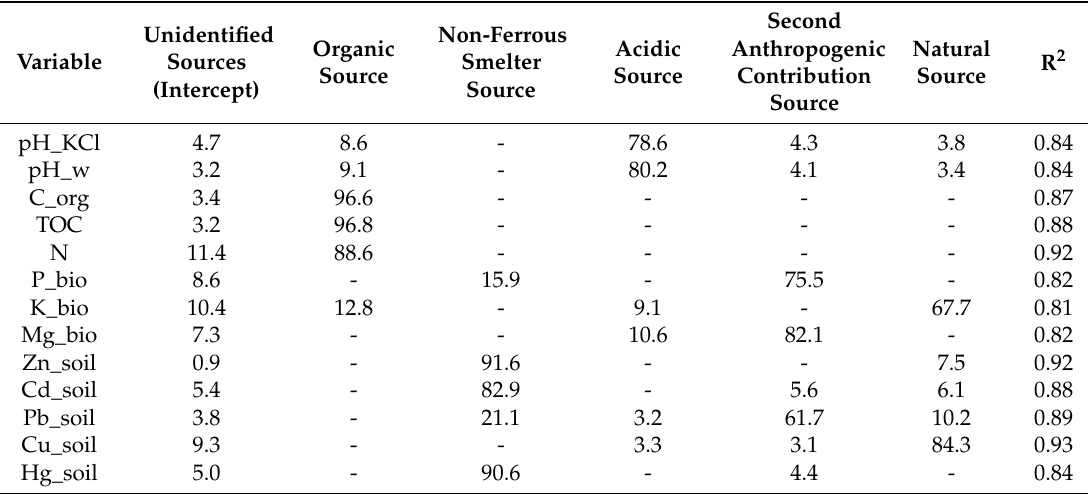
Table 3. Source apportionment